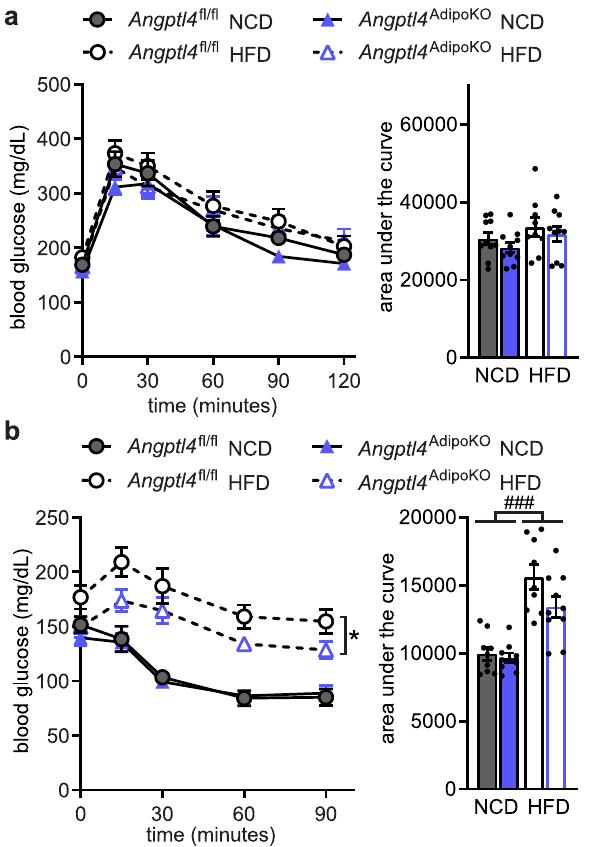
Figure 7. Glucose tolerance and insulin sensitivity of Angptl4 AdipoKO mice after chronic high fat feeding. ( a ) Glucose tolerance tests were performed on fasted (6 h) male Angptl4 fl/fl and Angptl4 AdipoKO mice after 24 weeks of either a normal chow diet (NCD) or high fat diet (HFD). Blood glucose concentrations were measured over 2 h after injection with glucose. Points represent glucose levels (mean ± SEM; n = 9–10) at each respective time point. Bar graphs represent area under the curve (mean ± SEM) for all time points. ( b ) Insulin tolerance tests were performed on fasted (4 h) male Angptl4 fl/fl and Angptl4 AdipoKO mice after 25 weeks of either a normal chow diet (NCD) or high fat diet (HFD). Blood glucose concentrations were measured over 90 min after injection with insulin. Points represent glucose levels (mean ± SEM; n = 9–10) at each respective time point. *p < 0.05 by repeated measures ANOVA. Bar graphs represent area under the curve (mean ± SEM) for all time points. ###p < 0.001 for dietary differences by two-way